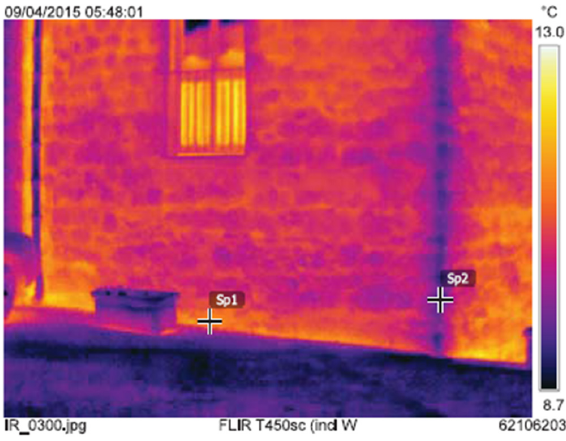
Figure 6. Exterior wall, South façade.